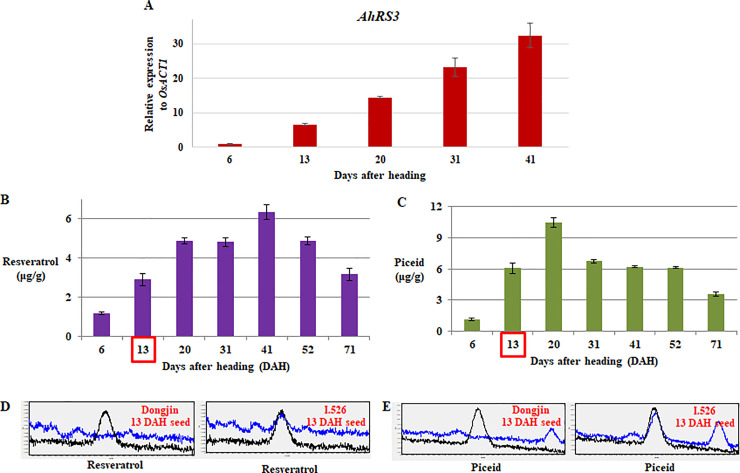
Analysis of AhRS3 expression and resveratrol and piceid biosynthesis in the developing seeds of I.526 at different time points.(A) Expression of AhRS3 relative to that of the rice ACTIN 1 (OsACT1) gene (internal control). (B, C) Levels of resveratrol (B) piceid (C) in I.526 seeds. (D, E) Chromatogram from UPLC analysis of resveratrol (D) and piceid (E). Black line indicates the standard, and blue line indicates the extract of Dongjin and I.526 seeds at 13 days after heading (DAH). Data represent mean ± standard deviation (SD).